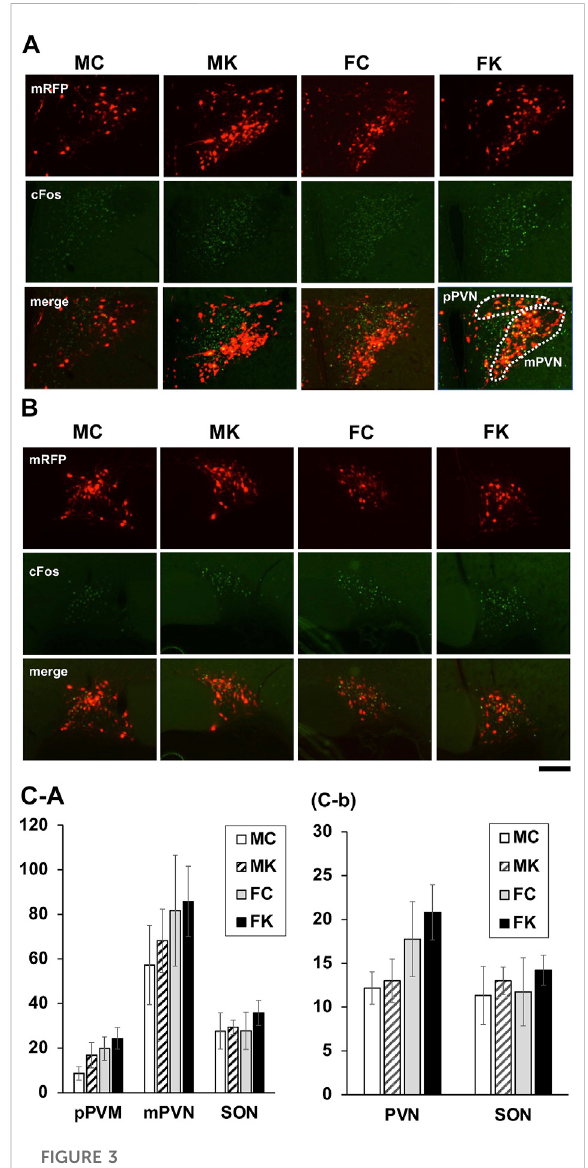
FIGURE 3 Oxytocin expression in hypothalamus (A) Oxytocin- monomeric red fl uorescent protein 1 (OXT-mRFP1) fl uorescence was observed by fl uorescence microscopy in the parvocellular paraventricular nucleus (pPVN), magnocellular paraventricular nucleus (mPVN), supraoptic nucleus (SON) and Posterior Pituitary (PP) in each the male control group (MC), male Kamikihi-to (KKT)-treated group (MK), female control group (FC) and female KKT-treated group (FK) ( n = 6 per group at each test). The images are represented in grayscale, white is high intensity of red fl uorescent. Scale bars = 100 μ m. (B) Intensity of mRFP1 fl uorescence was observed and is presented as % of male control group. The data are presented as the mean ± standard error of the mean. * p < 0.05 compared to male control